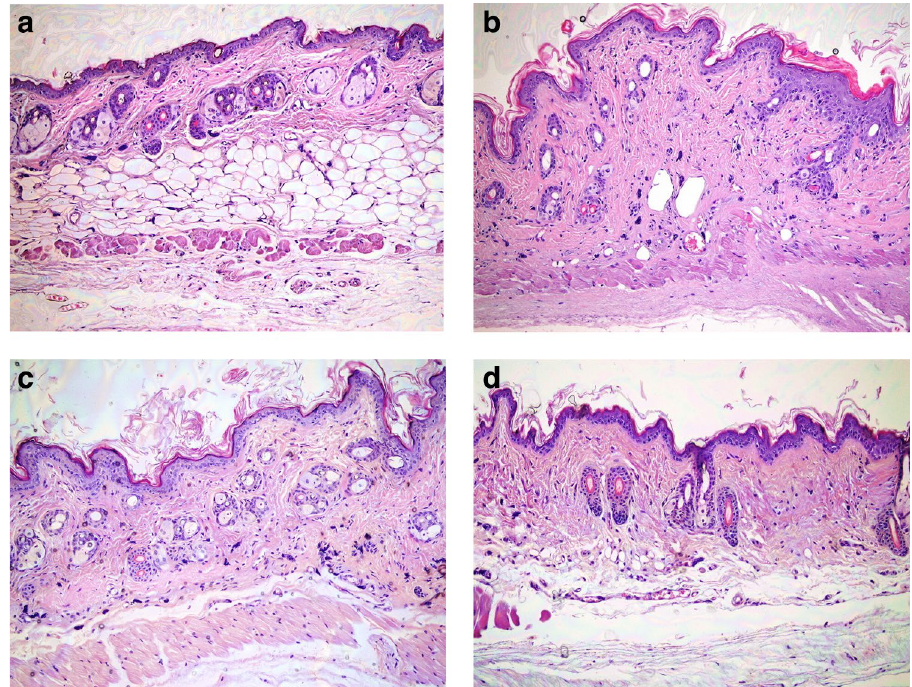
Figure 1. Histopathological studies from sections of skin in the study groups (hematoxylin and eosin staining, ×100). Normal histopathological view of mice immunised with PBS in control group ( a ). Increased dermal thickness, infiltration of inflammatory cell and fibrosis in the BLM-injected sham group ( b ). Tofacitinib ( c ) and metformin ( d ) applications decreased the dermal thickness, infiltrations of inflammatory cell and fibrosis in the BLM-injected